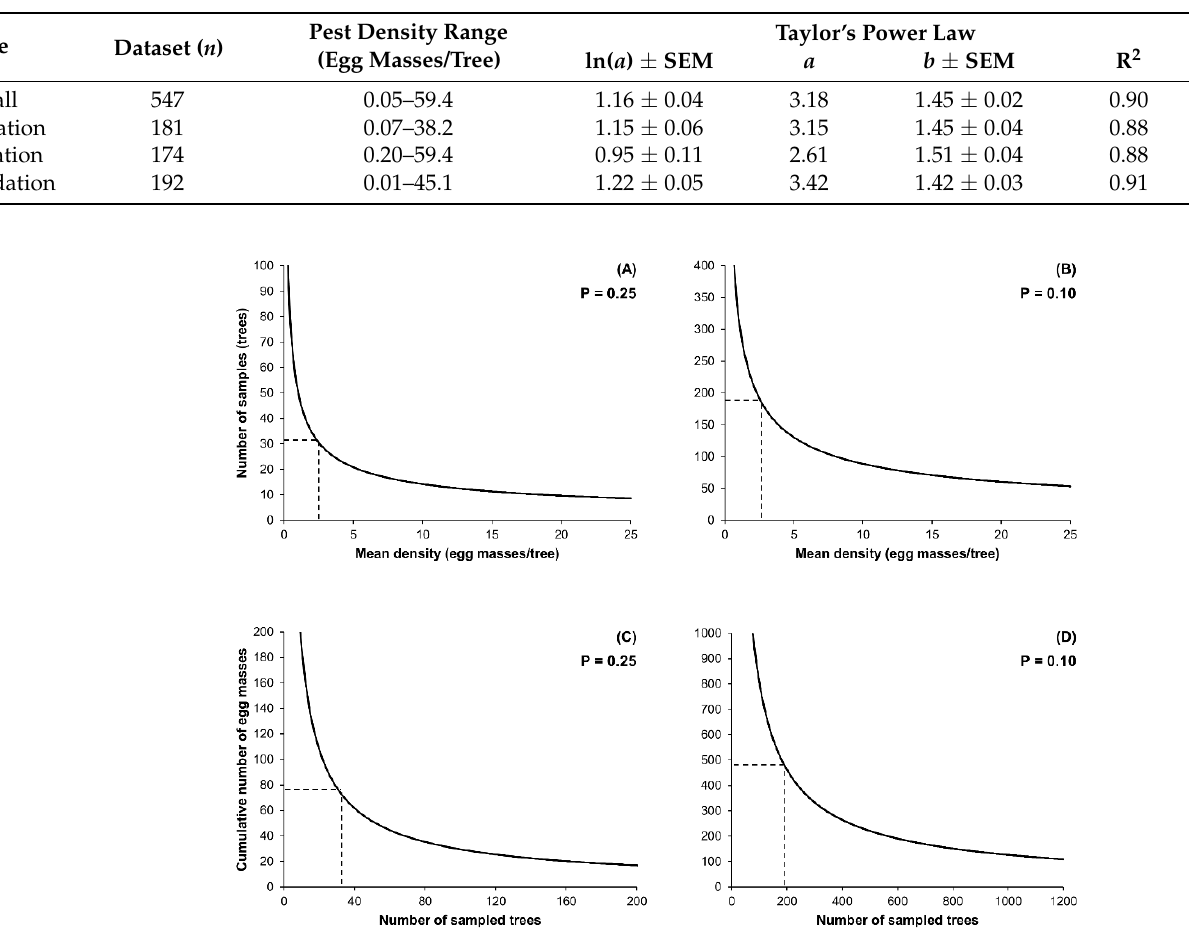
Figure 1. Sample sizes ( A , B ) and sequential stop lines ( C , D ) for the assessment of Lymantria dispar egg mass density on cork oak trees using Green’s method at D = 0.25 ( A , C ) and D = 0.10 ( B , D ).